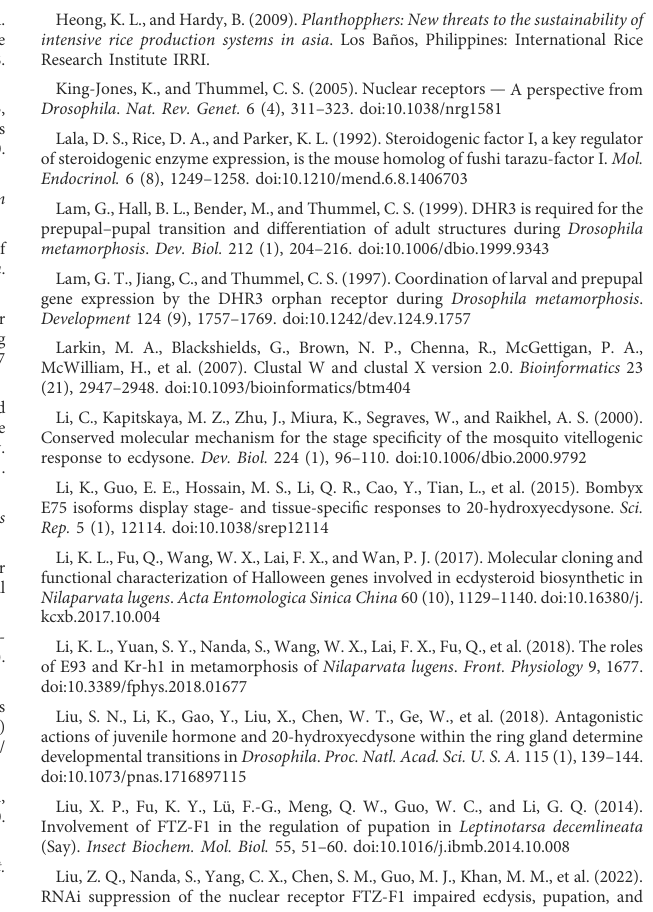
SUPPLEMENTARY FIGURE S3 Effect of the knockdown of NlHR3 and NlFTZ-F1 on the expression of NlEcR. (A) Effect of knockdown of NlHR3 on the expression of NlEcR. (B) Effect of knockdown of NlFTZ-F1 on the expression of NlEcR. SE was determined from three independent biological replicates, each with three technical